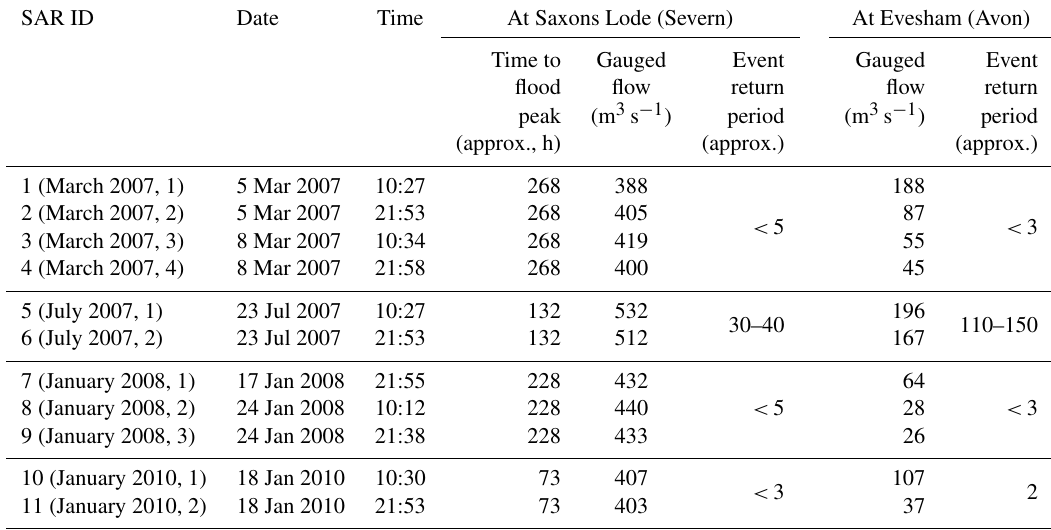
Table 2. The European Space Agency (ESA) sourced ENVISAT ASAR WSM acquisitions used with equivalent flow and return period data for rivers Avon and Severn; gauged data were obtained from the EA.